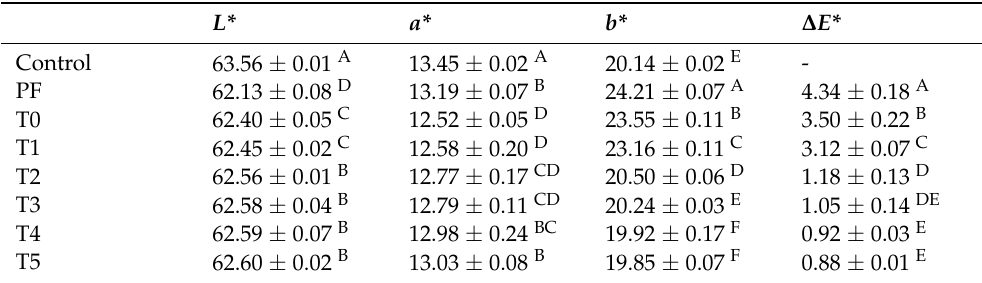
Table 6. Color of phosphate-containing frankfurters or phosphate-free frankfurters added with the combination of L-Arg and PC. L* a* b* ∆ E* Control 63.56 ± 0.01 A 13.45 ± 0.02 A 20.14 ± 0.02 E - PF 62.13 ± 0.08 D 13.19 ± 0.07 B 24.21 ± 0.07 A 4.34 ± 0.18 A T0 62.40 ± 0.05 C 12.52 ± 0.05 D 23.55 ± 0.11 B 3.50 ± 0.22 B T1 62.45 ± 0.02 C 12.58 ± 0.20 D 23.16 ± 0.11 C 3.12 ± 0.07 C T2 62.56 ± 0.01 B 12.77 ± 0.17 CD 20.50 ± 0.06 D 1.18 ± 0.13 D T3 62.58 ± 0.04 B 12.79 ± 0.11 CD 20.24 ± 0.03 E 1.05 ± 0.14 DE T4 62.59 ± 0.07 B 12.98 ± 0.24 BC 19.92 ± 0.17 F 0.92 ± 0.03 E T5 62.60 ± 0.02 B 13.03 ± 0.08 B 19.85 ± 0.07 F 0.88 ± 0.01 E Values are given as means ± SD from triplicate determinations; A–F in each column represent statistically significant differences ( p < 0.05). PF group: no added phosphate. T0 group: 0.15% PC and no added phosphate. T1 group: 0.15% PC + 0.025% L-Arg, and no added phosphate. T2 group: 0.15% PC + 0.05% L-Arg, and no added phosphate. T3 group: 0.15% PC + 0.075% L-Arg, and no added phosphate. T4 group: 0.15% PC + 0.1% L-Arg, and no added phosphate. T5 group: 0.15% PC + 0.125% L-Arg, and no added phosphate. L* : lightness, a* : redness/greenness, b* : yellowness/blueness, ∆ E* : the total color